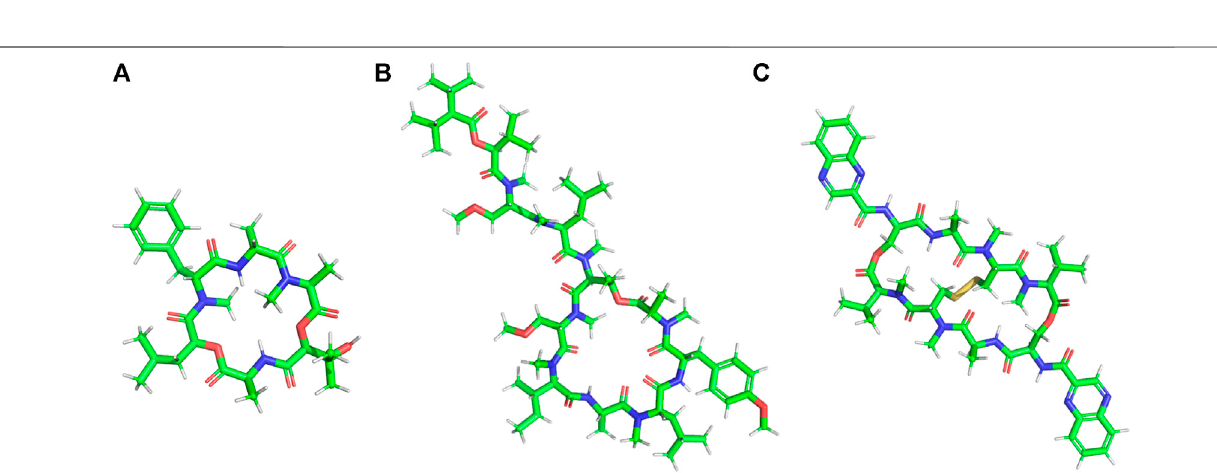
Frontiers in Chemistry |